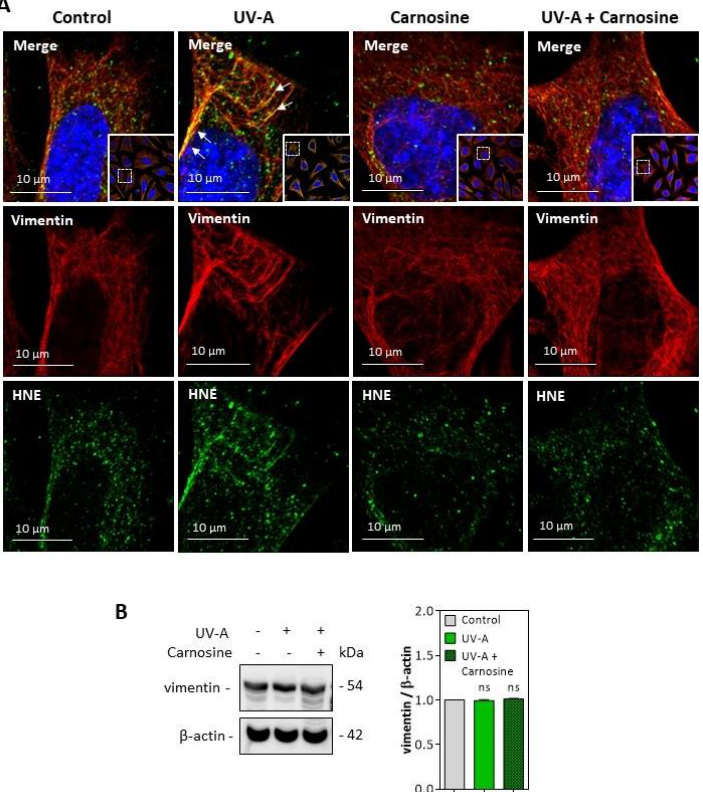
Figure 6. HNE adduct formation on vimentin in UV-A-exposed fibroblasts. ( A ) representative confocal imaging pictures showing the presence of HNE adducts (green, lower panels) on vimentin filaments (red, middle panels), and the merge (yellow, upper panel), in fibroblasts exposed to UV-A ± carnosine. White arrows indicate the colocalization areas (merge pictures). Nuclei were stained with DAPI (blue). Scale bar, 10 µ m. ( B ) , Expression of vimentin in fibroblasts exposed to UV-A, and effect of carnosine. These results are the mean of three separate experiments and are expressed as means ± SEM. Statistical analysis was assessed using a Student t -test. ns, non-significant.